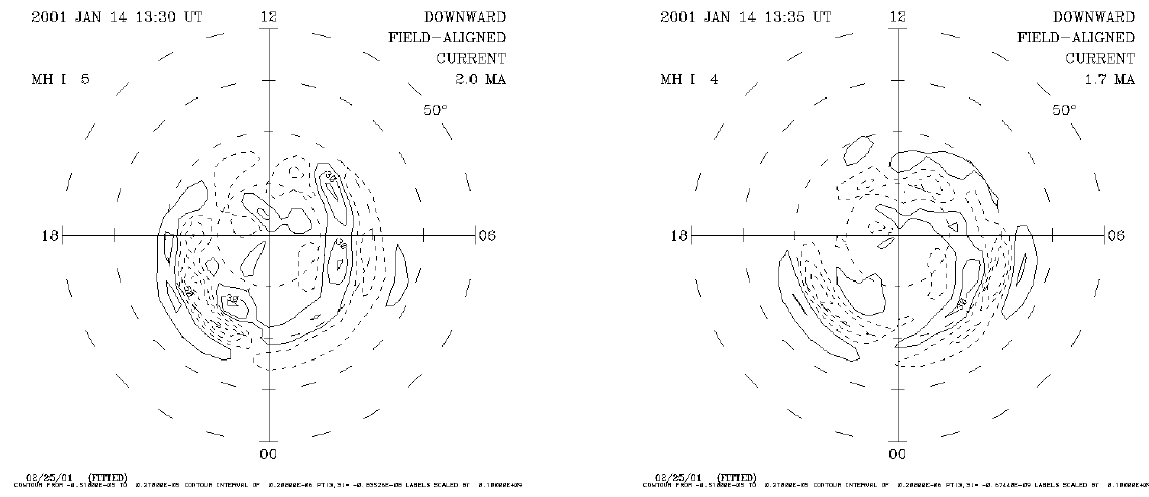
Fig. 7b. Global iso-contour patterns of field-aligned current flow (downward FAC – full contour lines; upward FAC – broken contour lines), derived using the AMIE technique for the same times and reference frames as Fig.